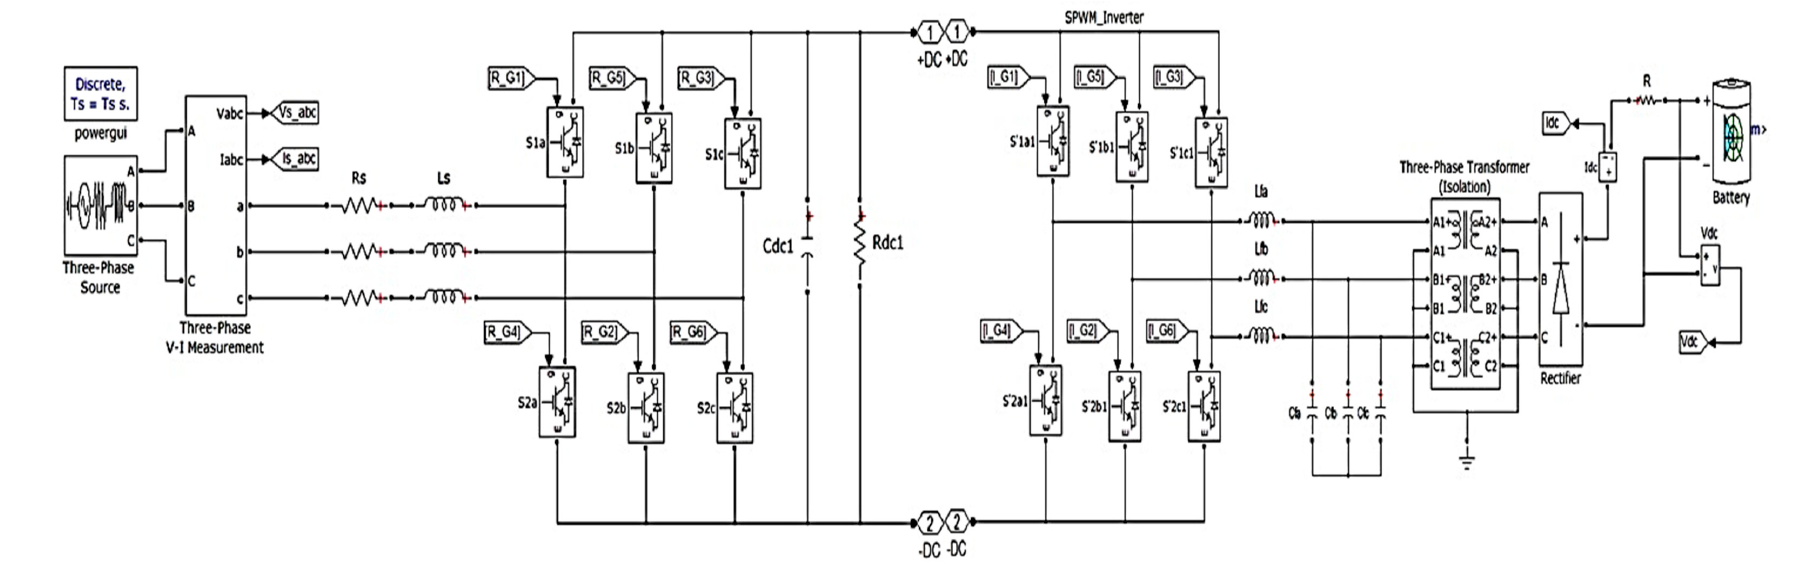
Figure 7. The simulation circuit of EV fast charger.